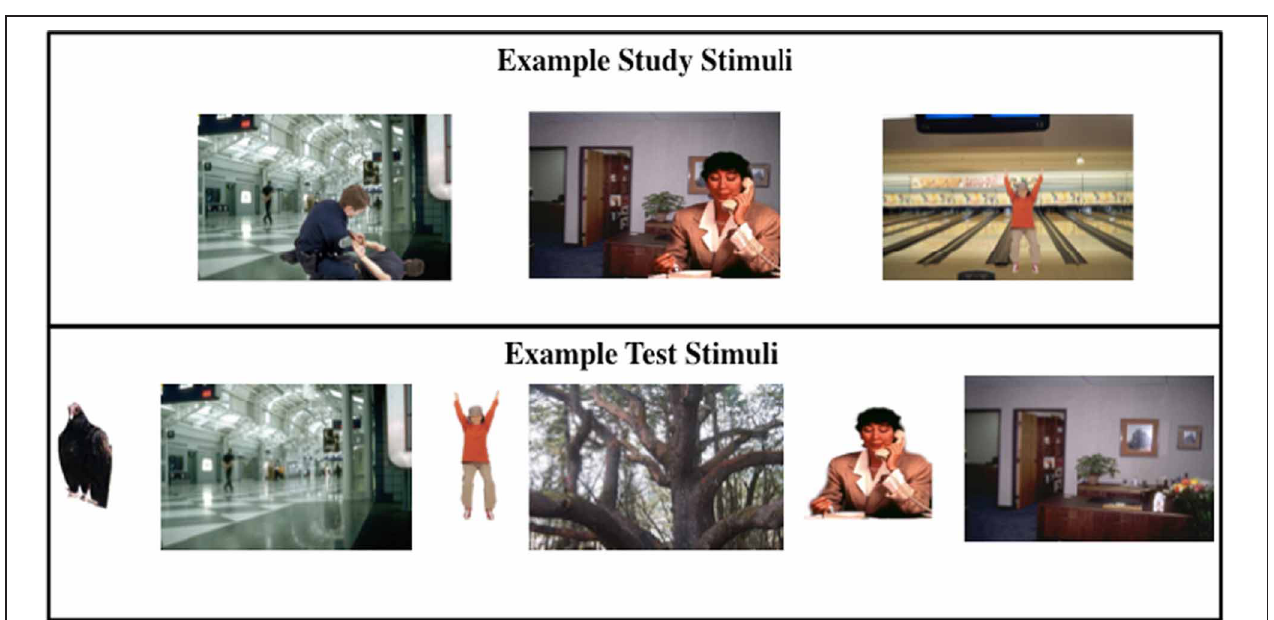
FIGURE 1 | Example stimuli from the study and test